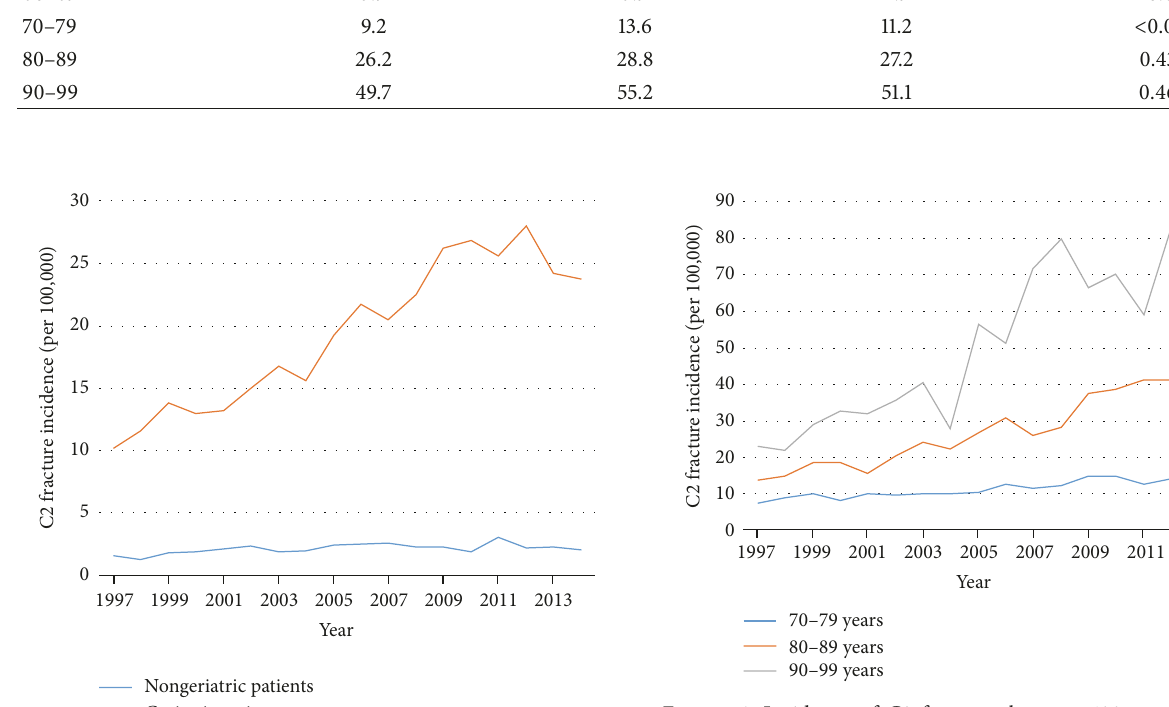
Figure 4: Incidence of C2 fractures between 1997 and 2014 per 100,000 in geriatric age categories: 70–79 years (blue), 80–89 years (orange), and 90–99 years